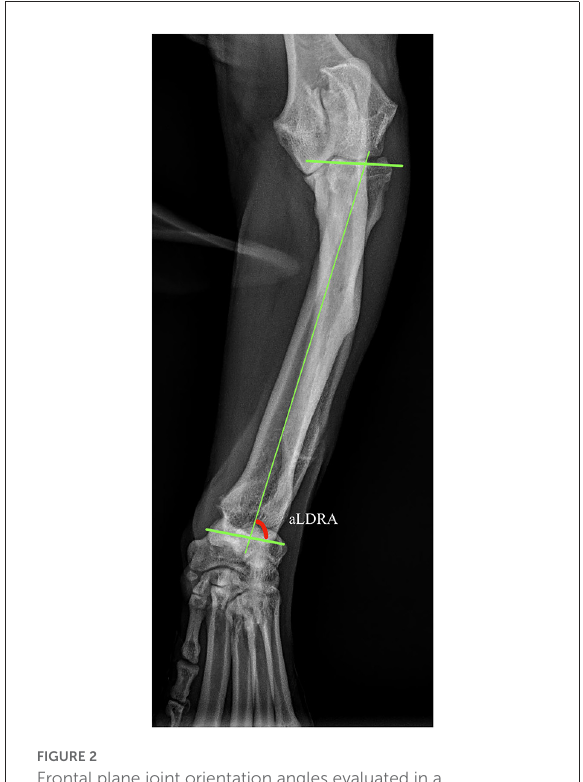
FIGURE2 Frontal plane joint orientation angles evaluated in a representative dorsal palmar projection.